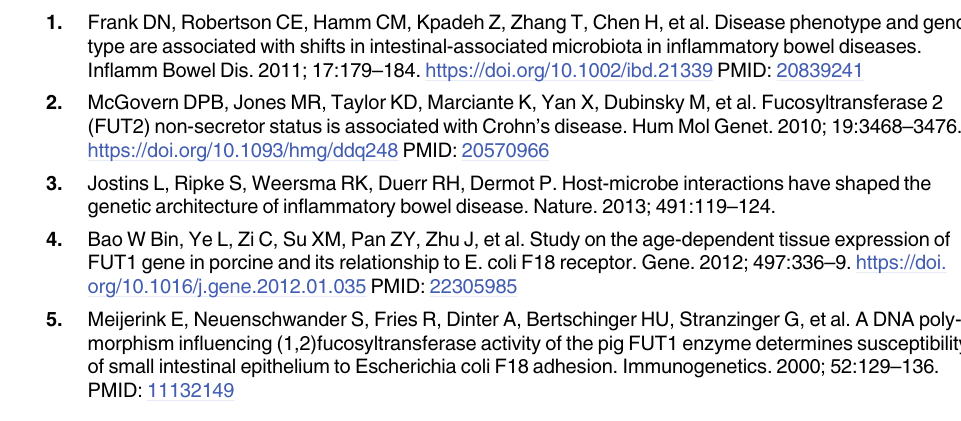
S2 Table. Relative expression of selected genes in mucosa from the stomach, ileum, caecum and mid colon of piglets 34 days of age (one-week post-weaning) belong to FUT1 AG and FUT1 AA groups. S3 Table. Dry matter content (%) and pH of digesta from the gastrointestinal tract of 34 days old piglets (one-week post-weaning) 1